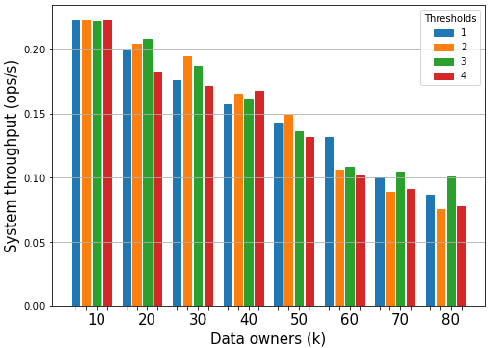
Figure 11. System throughput considering a round as a single operation, i.e., aggregating the results for each single operation, while varying t and k